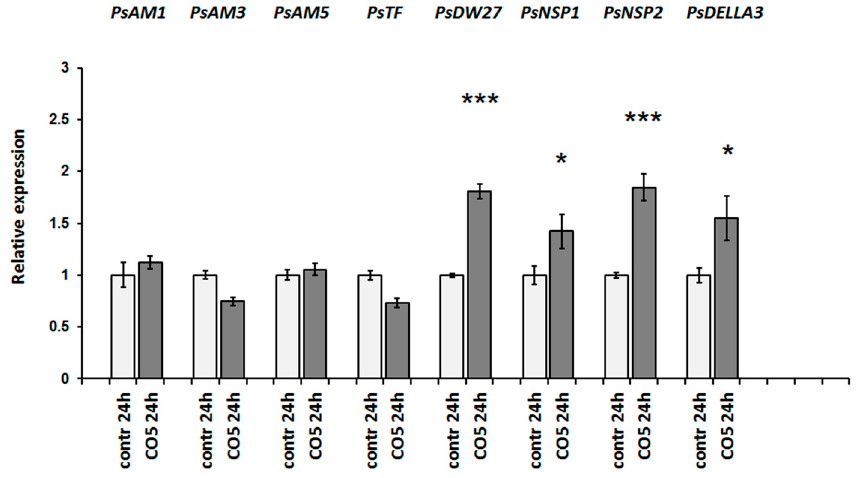
Figure 7. Quantitative reverse transcription polymerase chain reaction (qRT-PCR) analysis of transcription levels of the AM symbiosis-related marker genes in pea roots treated with 10 − 5 M CO5 for 24 h. As a control mock-treated plants were used. The relative expression was normalized against the constitutively expressed ubiquitin and actin genes. Values are means ± SEM of three technical repeats. The graphs show the results of one biological repeat, representative for three biological independent experiments. Asterisks indicate statistically significant differences compared with the respective mock-treated control: *** p < 0.001, * p < 0.05.